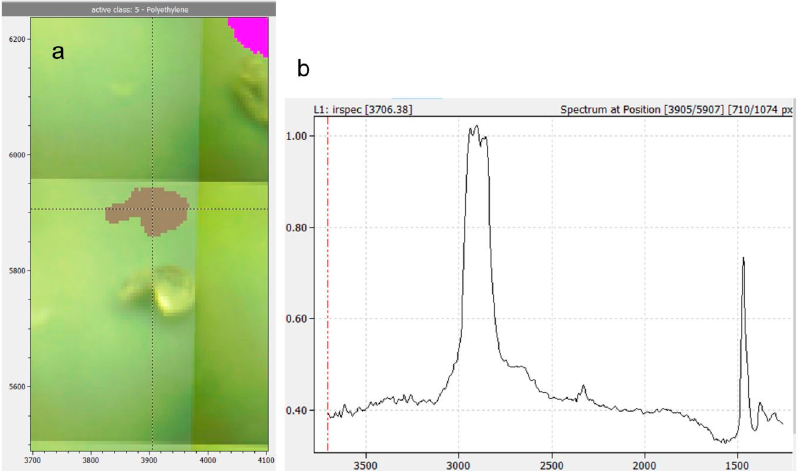
Figure 3. Shifted overlay of false color image and photograph of a PE particle (grey) and a PET particle (pink) ( a ). Axes in µm. Crosshairs indicate position of spectrum shown in ( b ): FTIR spectrum of the PE particle, absorption mode. Horizontal axis in wavenumbers, vertical axis dimensionless intensity counts.